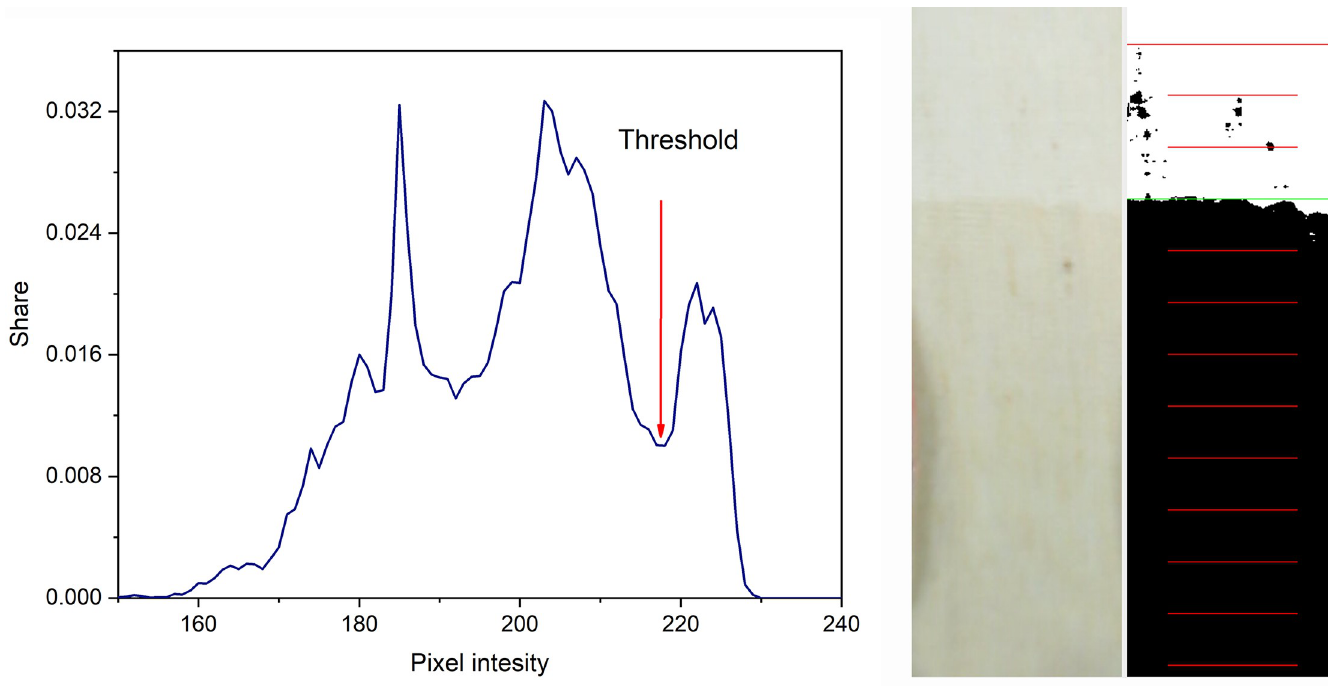
Fig 9. Example of a) “Problematic” histogram, and b) Original and thresholded section.